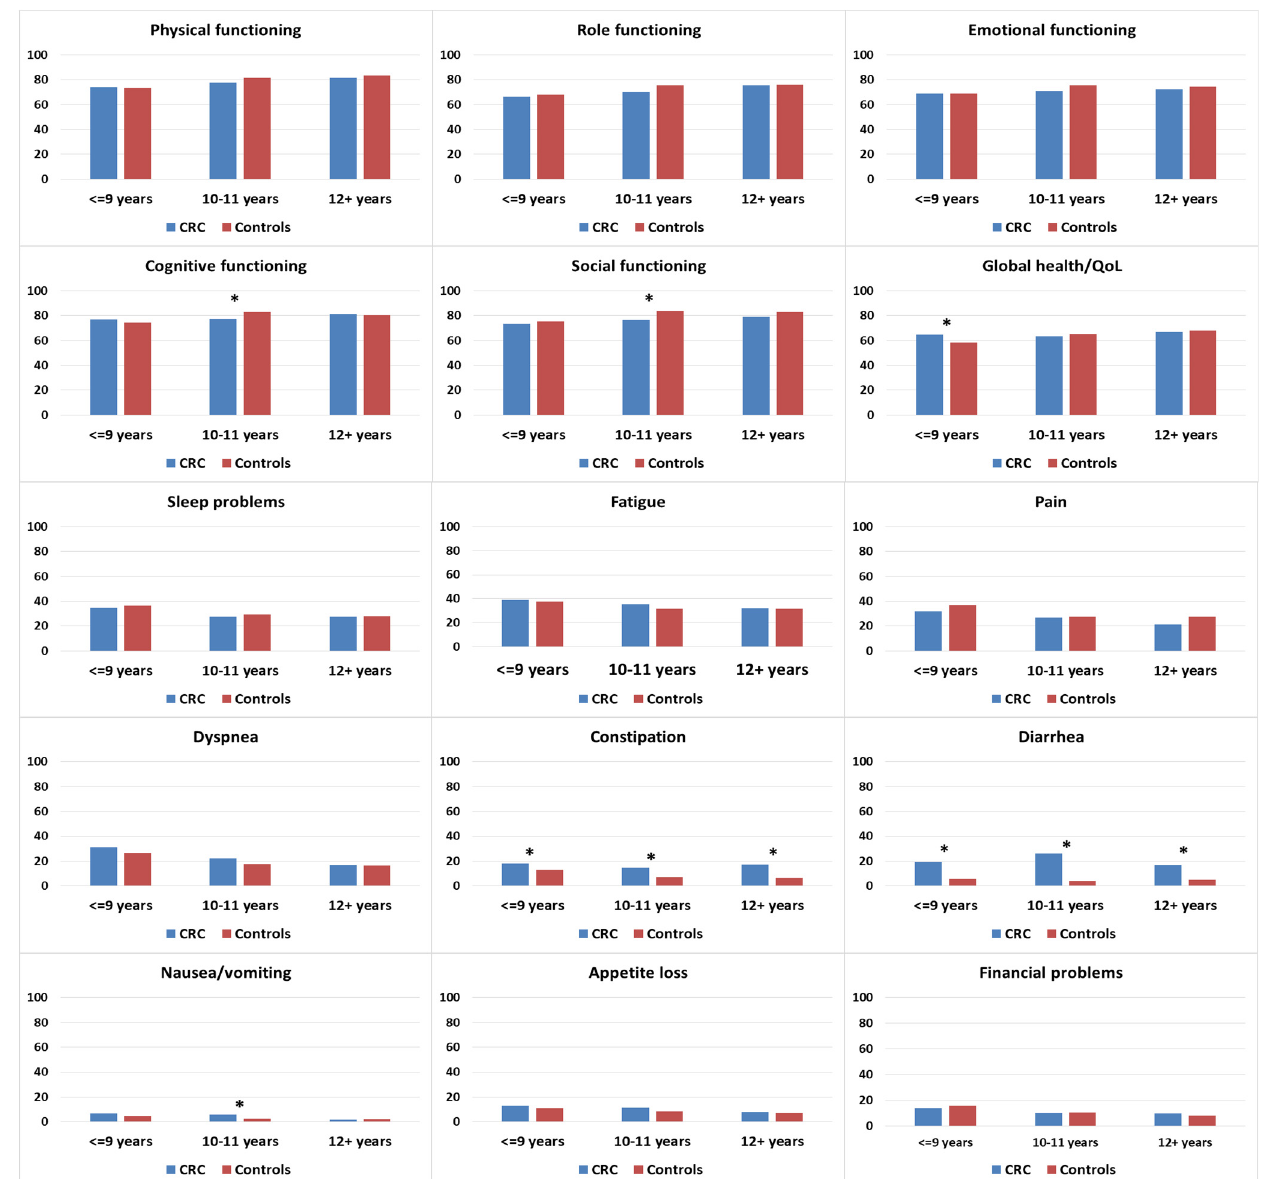
Figure 4. Mean EORTC QLQ-C30 scores of colorectal cancer (CRC survivors) and controls, stratified by education. Models are adjusted for age at survey and sex. Asterisks (*) indicate significantly significant differences ( p < 0.05) between the subgroups. All results are based on 25 imputations of missing values.